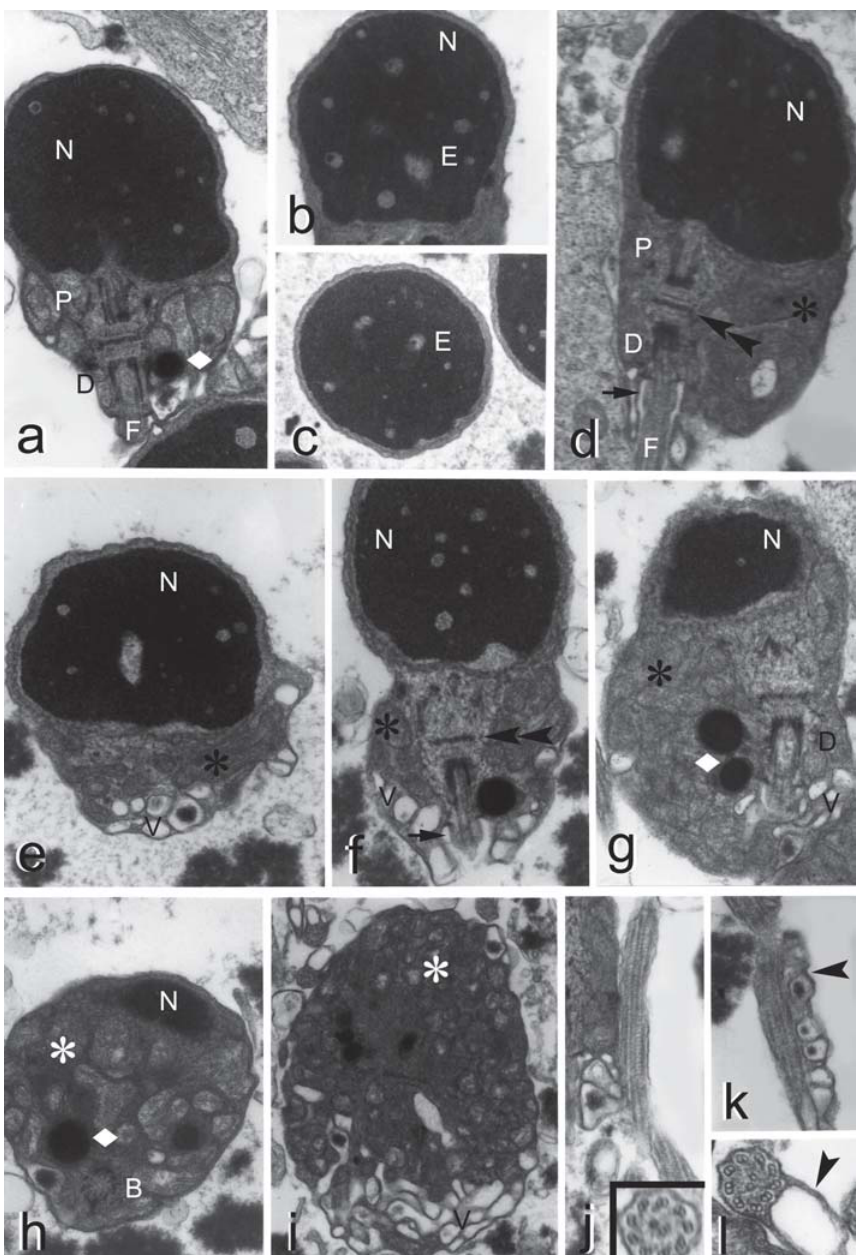
Fig. 6. Spermatozoa of Aspidoras poecilus . a ) Spermatozoon longitudinal section. b and c ) Nucleus in longitudinal and cross sections. d ) Centriolar arrangement. e to i ) Midpiece in longitudinal and transverse sections showing mitochondria, vesicles, cytoplasmic channel, and electron-dense circular structures. j and k ) Flagellum in longitudinal sections. j -inset and l ) Flagellum in cross sections. ( a, b, f, j, k ) X 23000; ( c, d ) X 17000; ( e ) X 22050; ( g, h ) X 25200; ( i ) X 18400; ( j -inset, l ) X 57500. B: basal body; D: distal centriole; E: electron-dense structure; F: flagellum; N: nucleus; P: proximal centriole; V: vesicles; Asterisk: mitochondria, Arrow: cytoplasmic channel; Arrowhead: lateral membranous compartment; Double arrowhead: electron-dense material between the centrioles; Lozenge: electron-dense circular